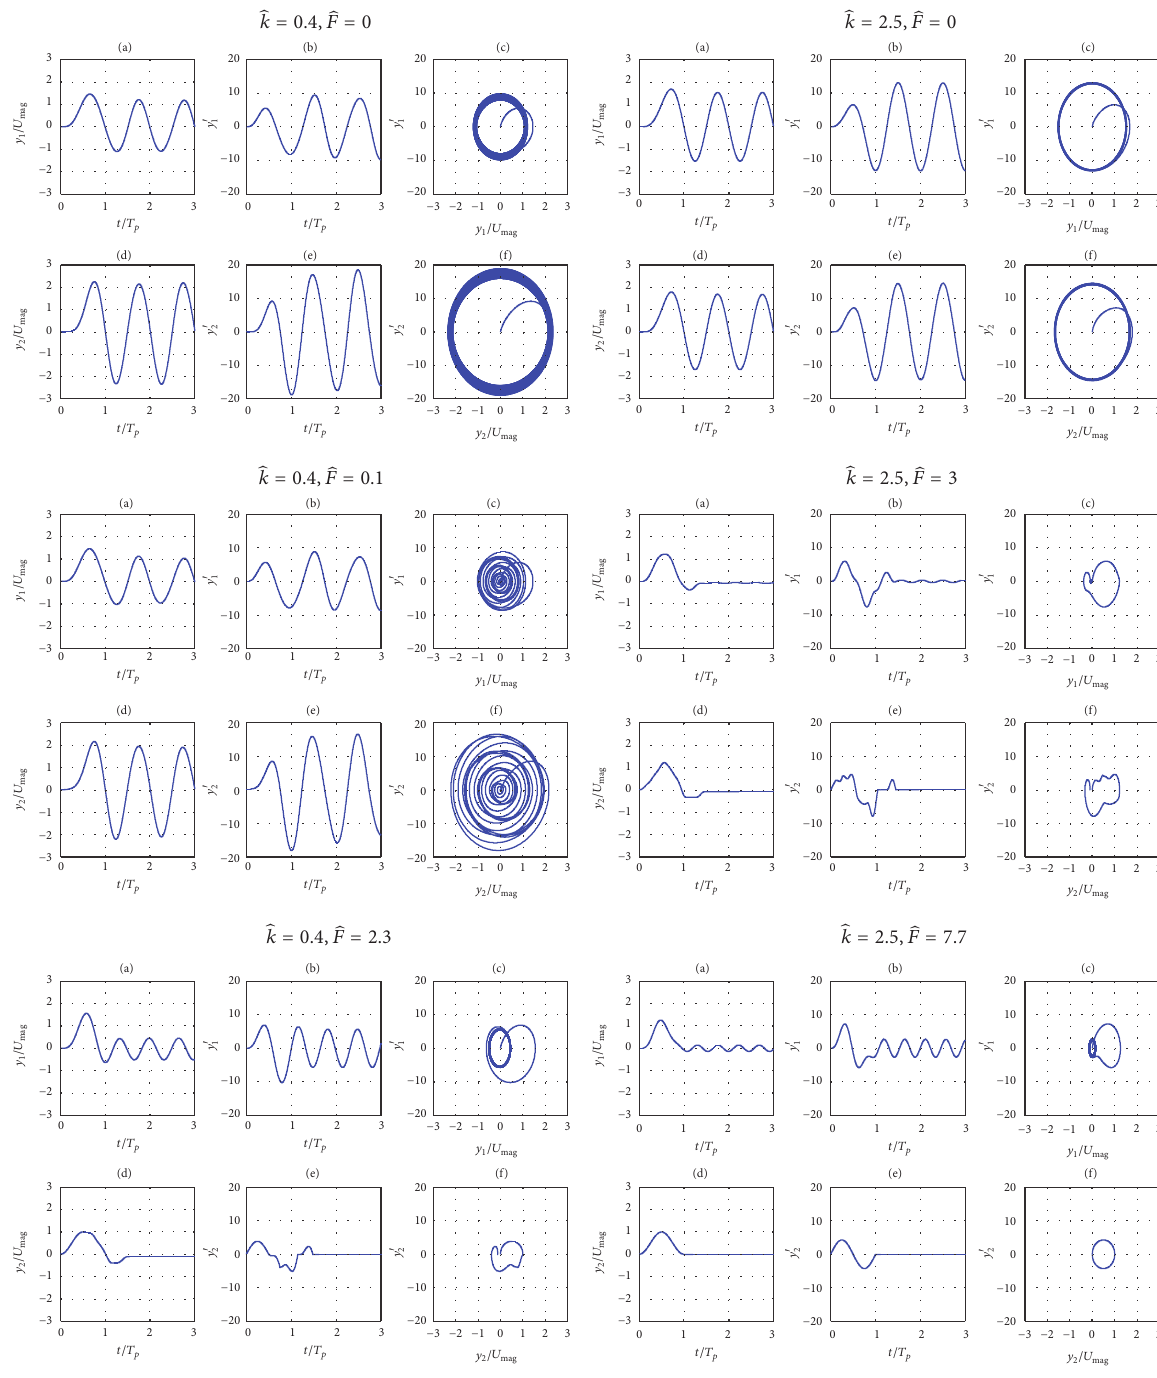
̂𝑘 = 0.4 ) and medium (frequency